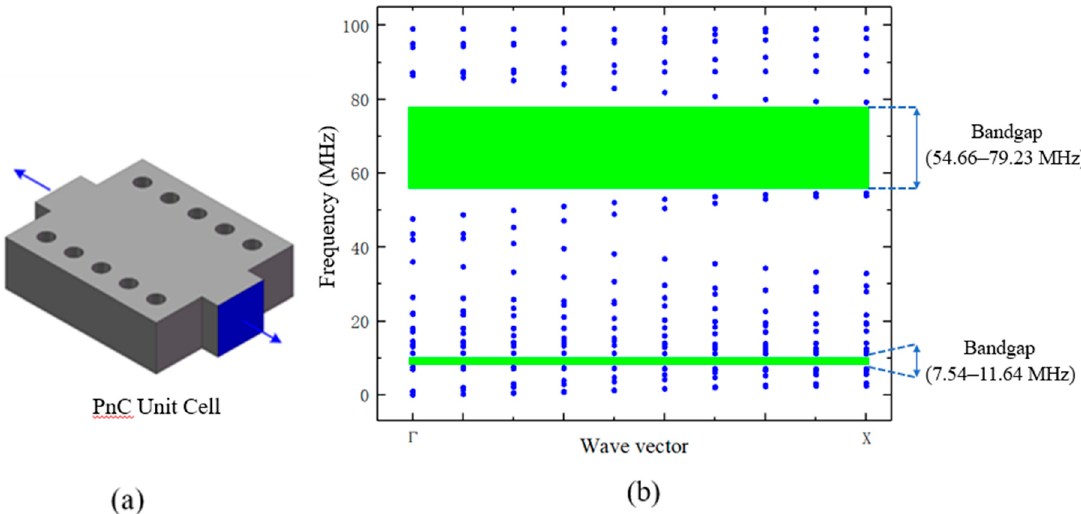
Figure 2. Band gap simulation results of PnC units. ( a )the blue surface and arrows indicate the position and direction of the applied Bloch boundary conditions; ( b )the band gap simulation results of the PnC.